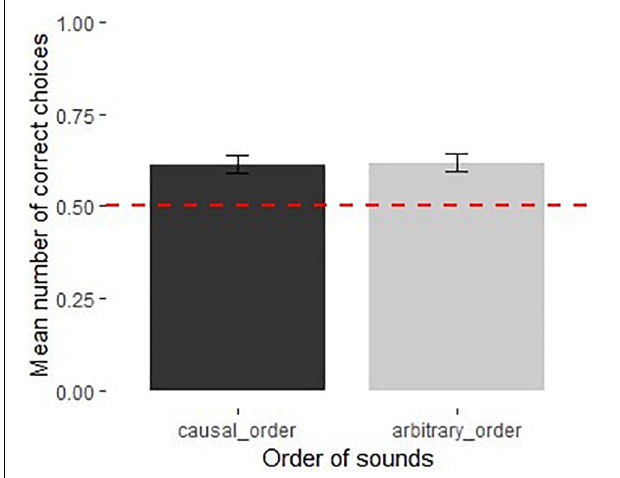
FIGURE 3 | Performance of children in the causal and arbitrary recorded sound orders in Experiment 2 ( N = 40). Dotted line shows chance level performance ( p = 0.05), error bars represent SE